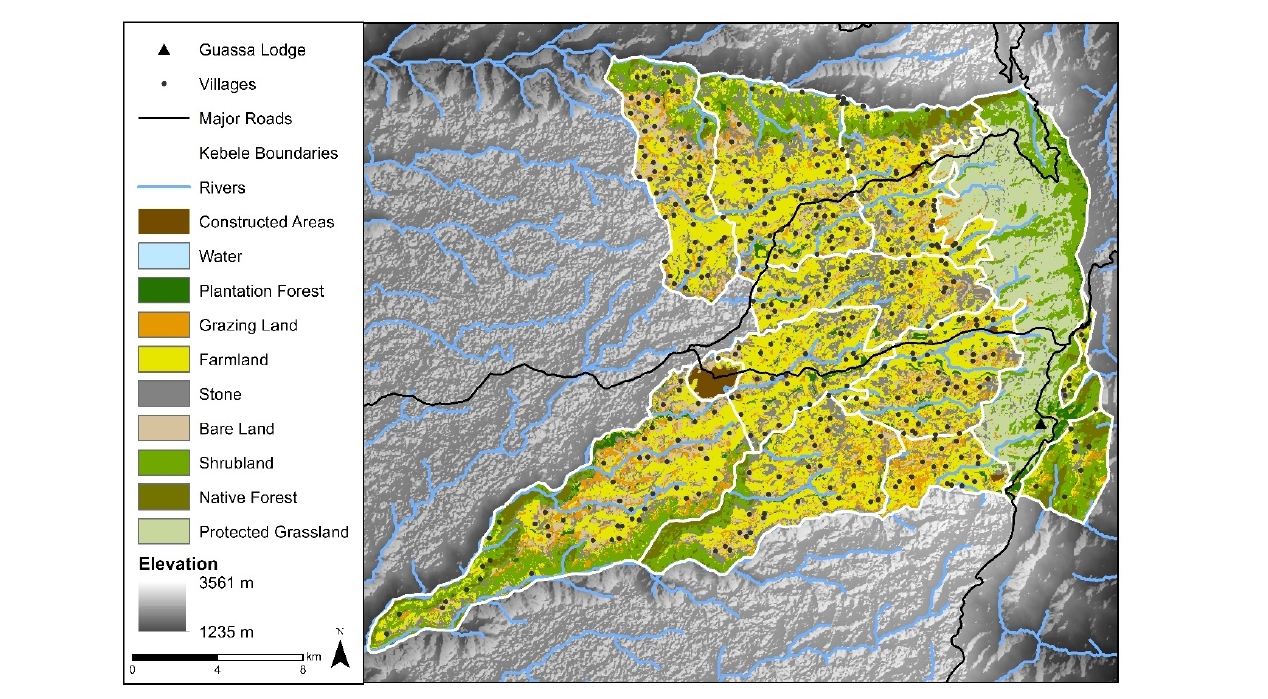
Fig. 3 . Classification of the study area using locally defined land